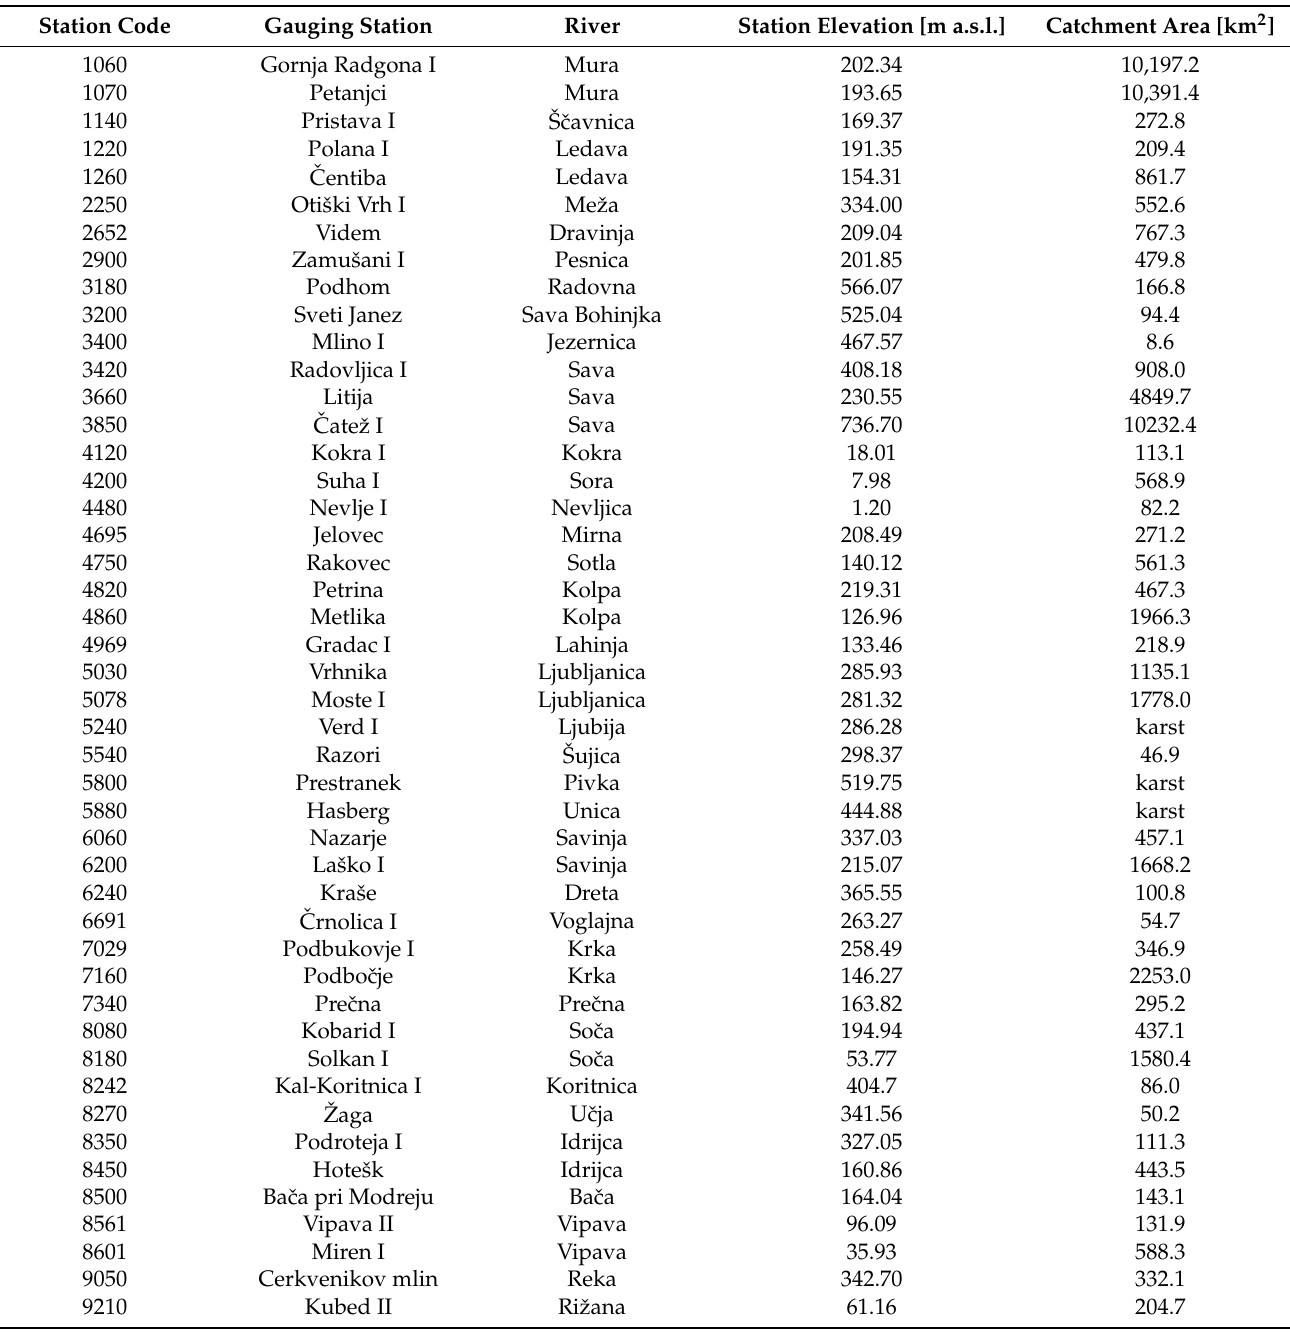
Table 1. Main characteristics of the considered gauging